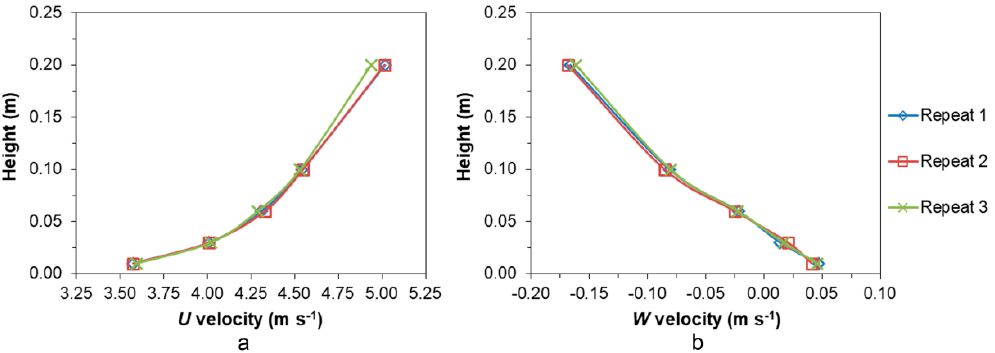
Figure 4. Reproducibility study for air velocity measurements in the wind tunnel without scaled model for free stream wind speed of 8 m·s − 1 . ( a ) and ( b ) represent streamwise ( U ) and vertical ( W ) air velocity components, respectively.